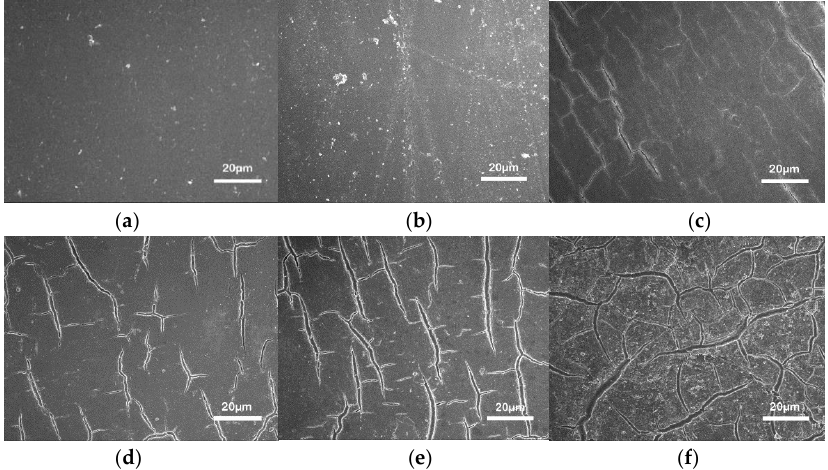
Figure 6. SEM of polyurea—( a ) 0-day aged; ( b ) 30-days aged; ( c ) 60-days aged; ( d ) 90-days aged; ( e ) 120-days aged; and ( f ) 150-days aged.